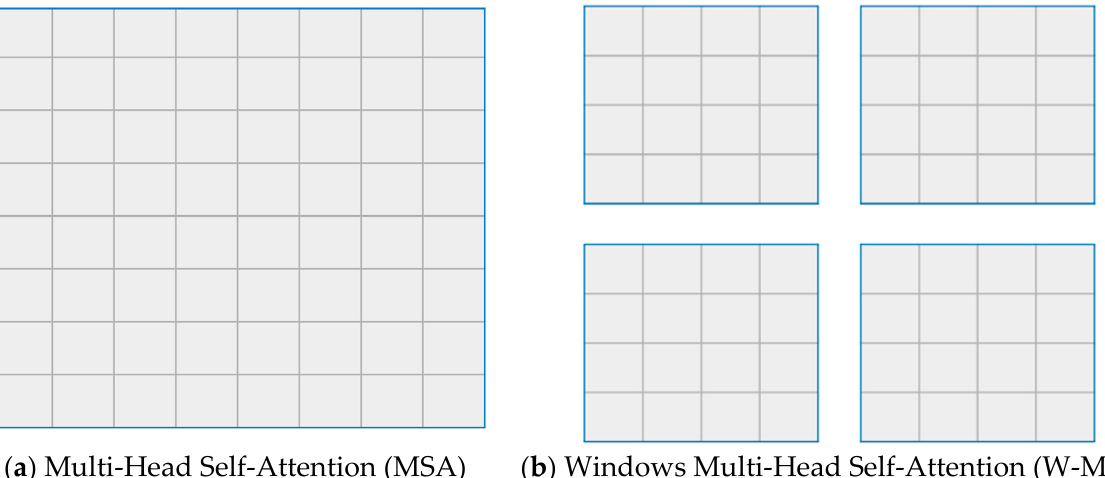
Figure 6. Multi-Head Self-Attention and Windows Multi-Head Self-Attention. ( a ) Self-attention is computed for the whole feature map, which is computationally intensive. ( b ) The whole feature map is divided into four windows, and the self-attention in each window is computed in parallel, reducing the calculation amount and improving the computational efficiency.